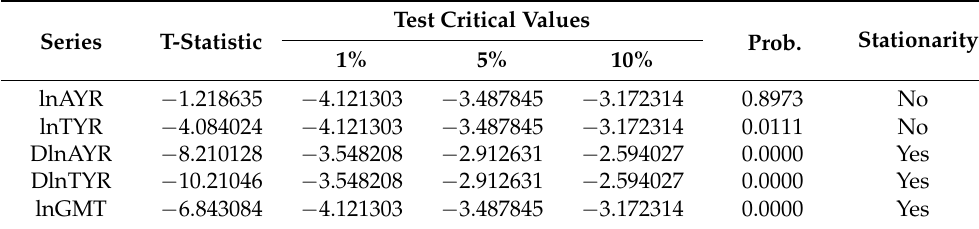
Table 2. Results of series’ stationarity test for average and top yields of world rice and global mean temperature from 1961 to